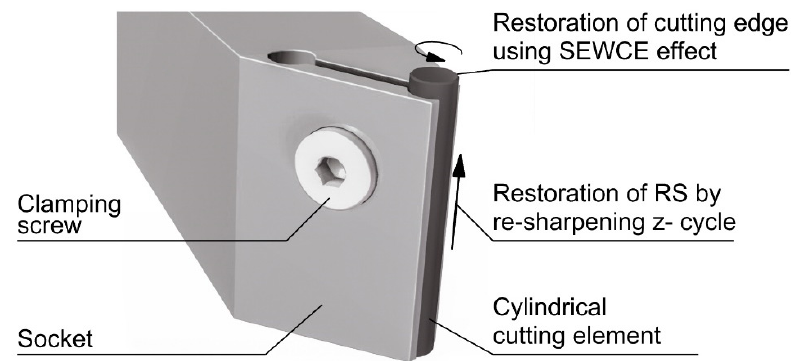
Figure 10. A virtual model of the tool ensuring the reproduction of cutting properties using the SEWCE effect and resharpening of the rake surface (RS).